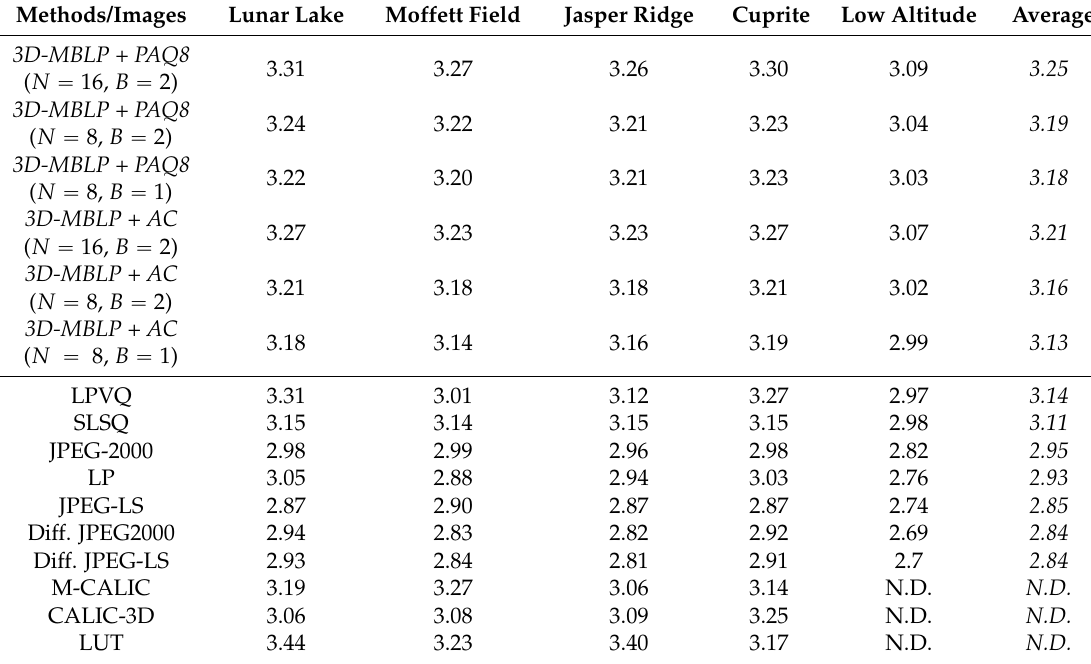
Table 10. Compression results, in terms of compression ratio (C.R.) achieved by LMBHI (by using various parameter configurations), compared to other lossless compression